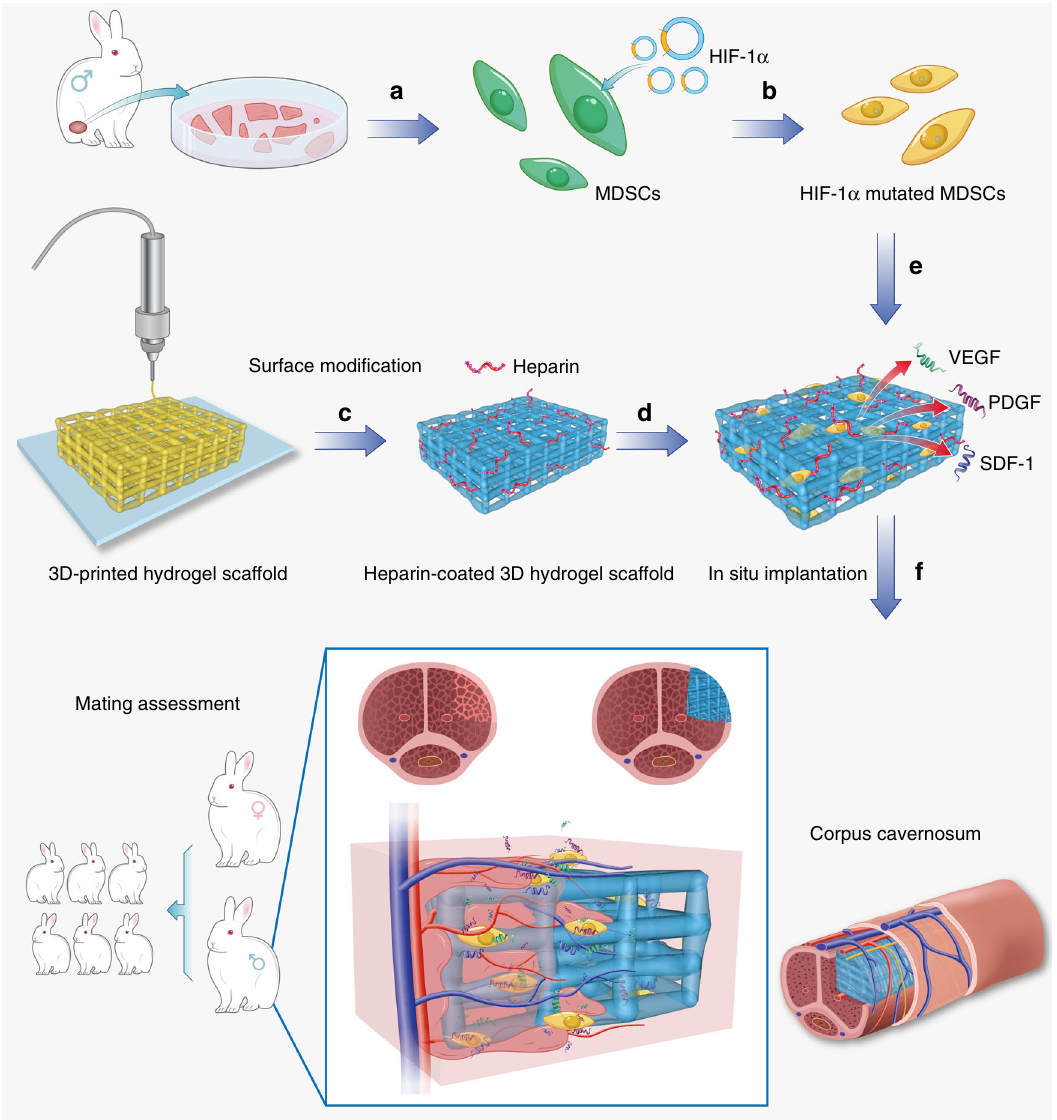
Fig. 1 The schematic illustration of repairing injured corpora cavernosa in rabbits. a The MDSCs were extracted from muscles of rabbit legs. b The HIF- 1 α -mutated MDSCs were obtained by lentiviral transfection. c 3D-printed hydrogel scaffold was prepared by 3D printing technology. d Heparin